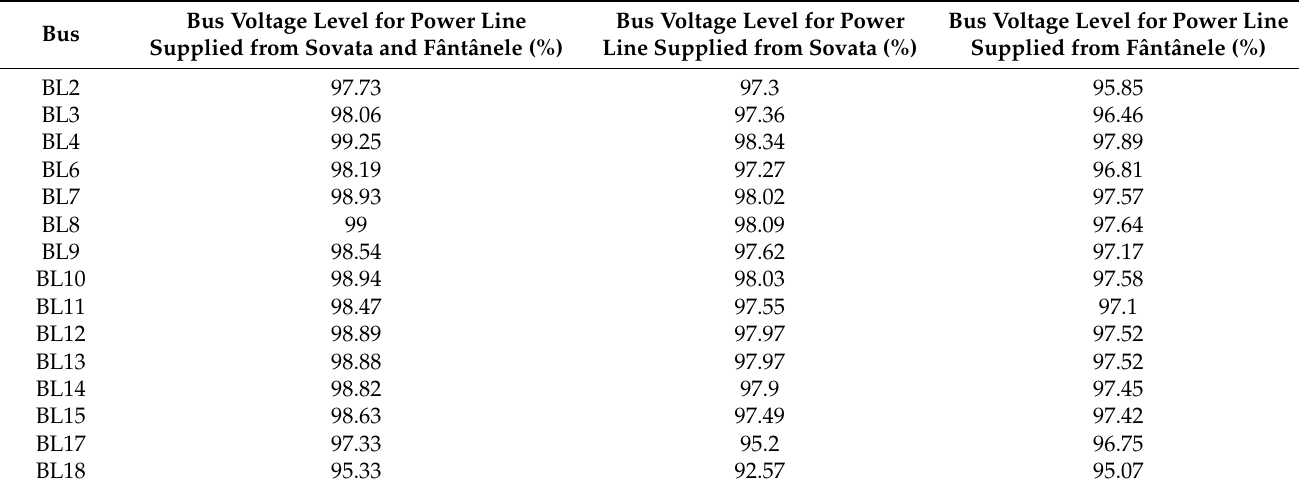
Table 7. Bus voltages without EVs.